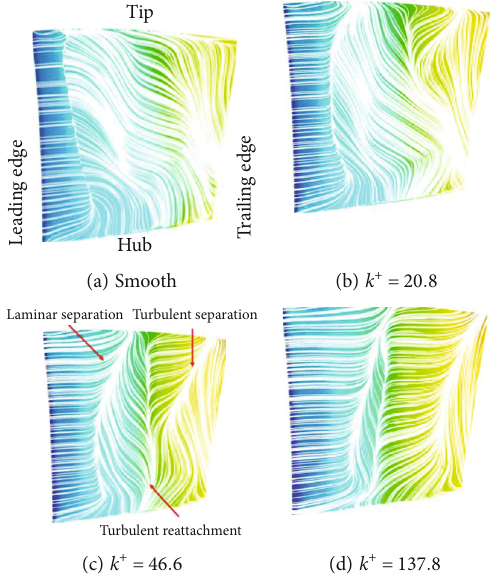
Figure 14: Limiting streamline on the rotor suction surface at di ff erent k + .